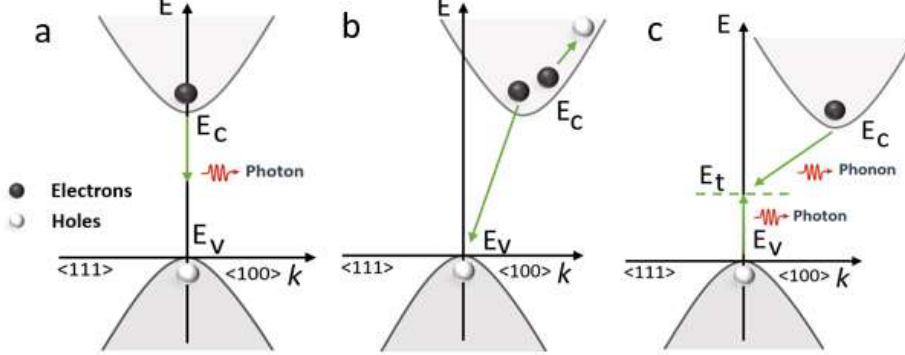
Figure 3. Photogenerated carrier recombination mechanism. ( a ) Radiative recombination, ( b ) Auger recombination and ( c ) SRH recombination using energy (E) momentum (K) diagram.